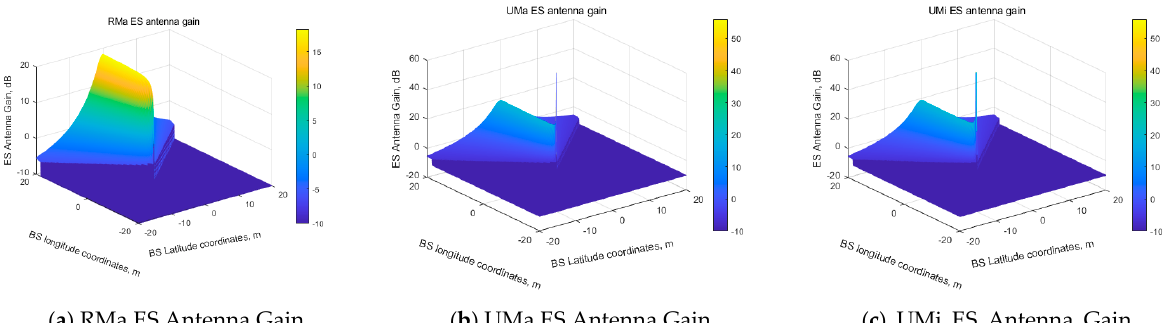
Figure 4. FSS ES antenna gain orientations.